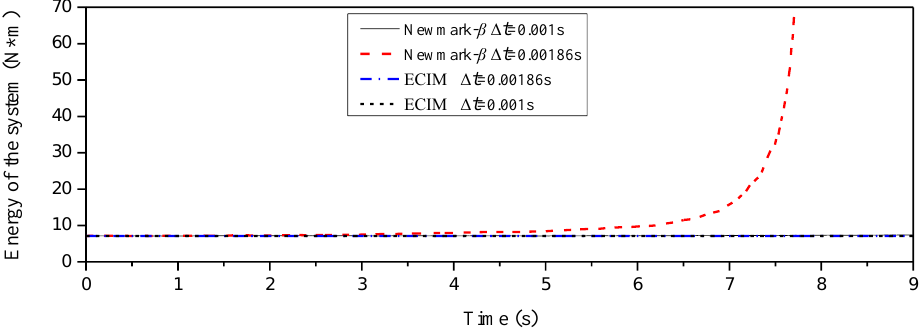
Figure 6. Energy of the system with different time integration methods.